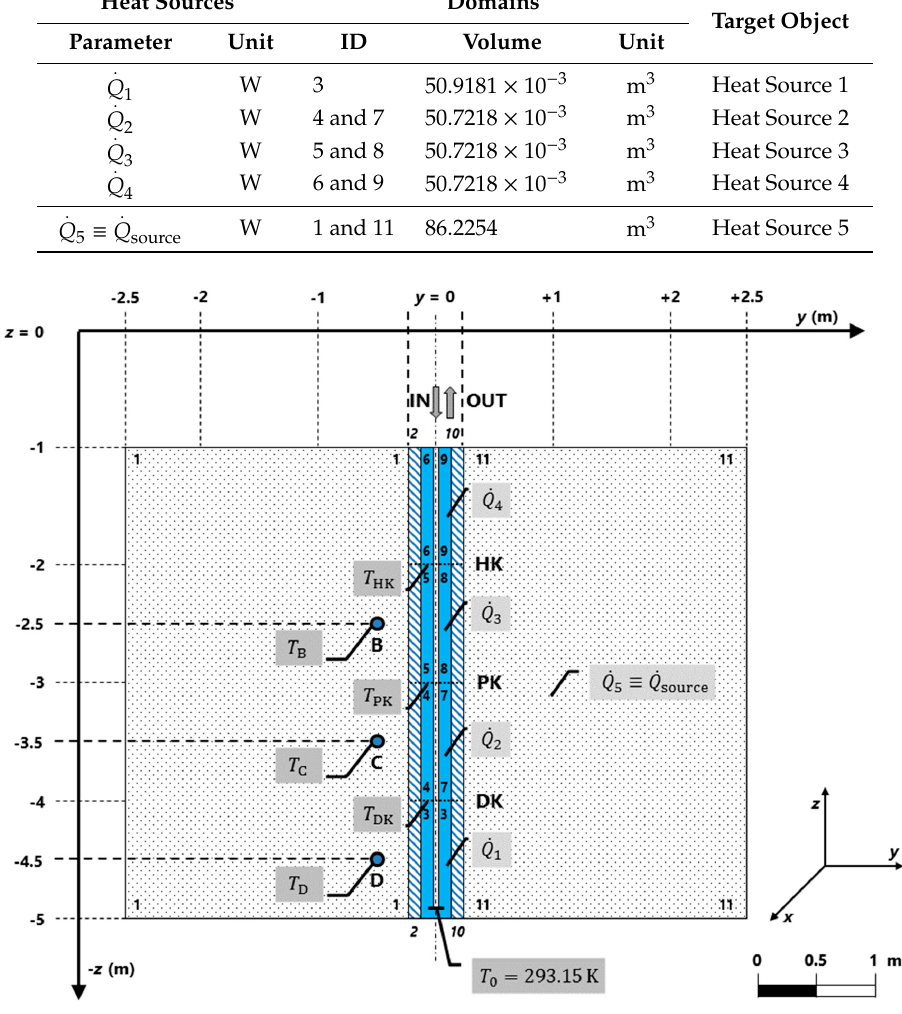
Figure 1. 2D conceptual model: location of the domains and their notification, heat sources, initial value of thermodynamic temperature, and chosen coordinate system ( yz-plane ).